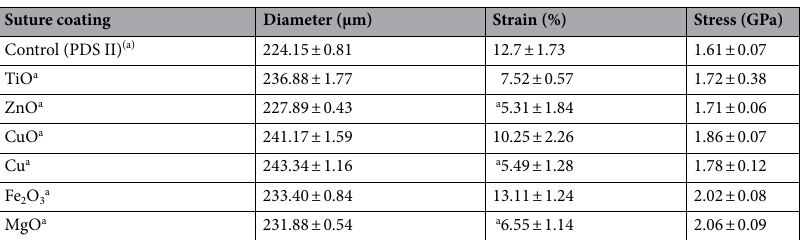
Table 1. Diameter, stress and strain values for suture conditions. All values represent stress and strain exerted on the suture at the moment of fracture indicating the maximum stress and strain. a ANOVA test p < 0.05— significant difference, n = 5.